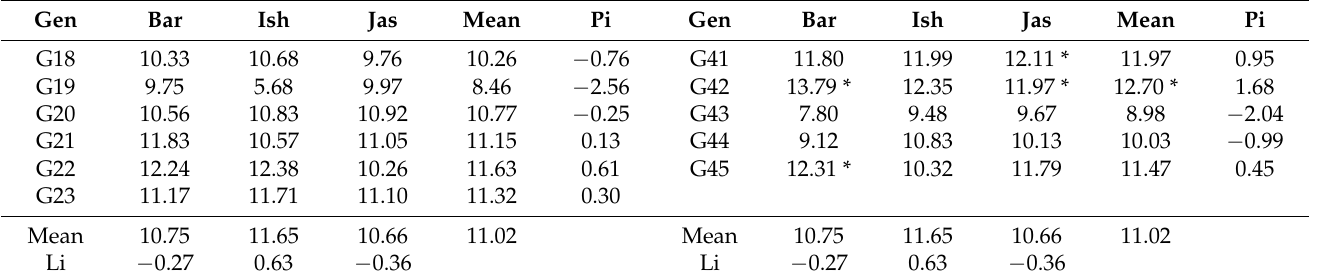
Table S2: Weather conditions prevailing for vegetative and reproductive phases during cropping period at different locations; Figure S1: Dendrogram showing clustering of different traits (left); the position of different traits depicted on biplot from principal component analysis for data on Barishal environment; Figure S2: Dendrogram showing clustering of different traits (left); the position of different traits depicted on biplot from principal component analysis for data on Ishwardi environ- ment; Figure S3: Dendrogram showing clustering of different traits (left); position of different traits depicted on biplot from principal component analysis for data on Jashore